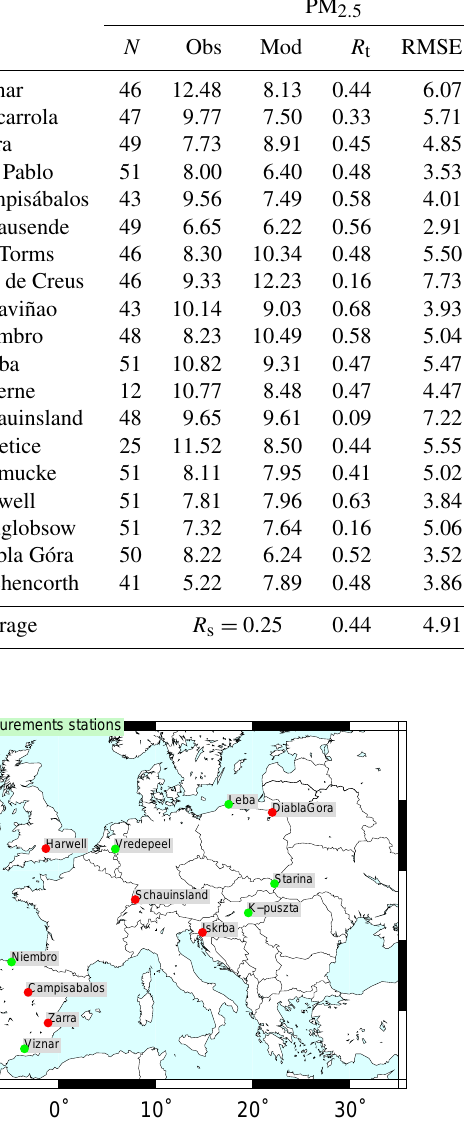
Figure 4. Location of the sites: (red symbols) surface time series of PM 2 . 5 speciations are presented in Fig. 5; (green symbols) time series of PM 10 for inorganic species are presented in Fig.